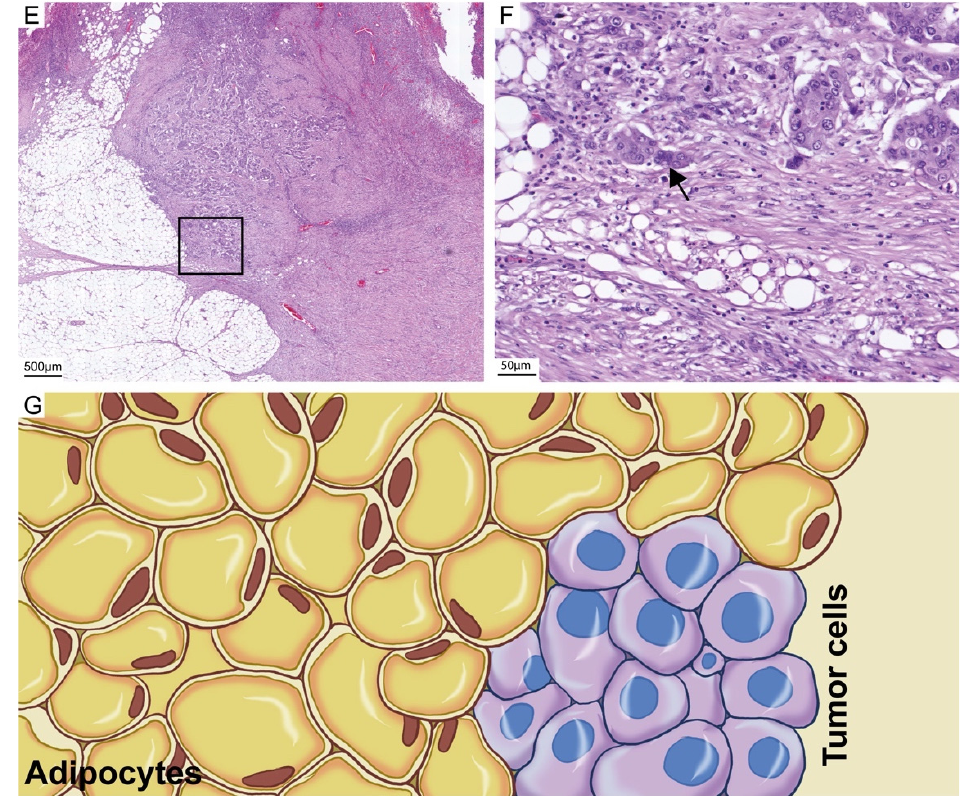
Figure 1. H & E images of SARIFA-positive and SARIFA-negative cases: SARIFA-positive cases ( A , C : scale bar 500 µm; B , D : scale bar 50 µm) SARIFA-negative case at the invasion front with a PDC (arrow) ( E : scale bar 500 µm, F ; scale bar 50 µm). Schematic representation of a SARIFA area with tumor cells directly adjacent to adipocytes without a stromal reaction ( G ).